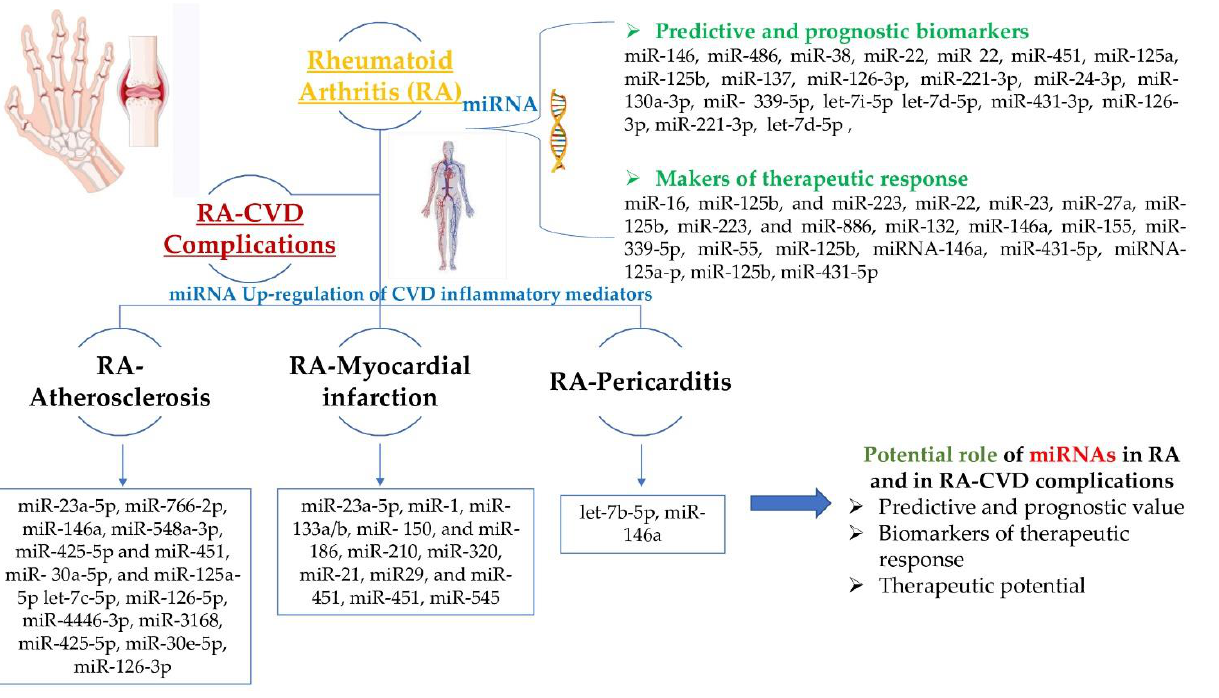
Figure 1. Summary of the involvement of specific miRNAs in RA and RA-CVD complications, and their potential value.